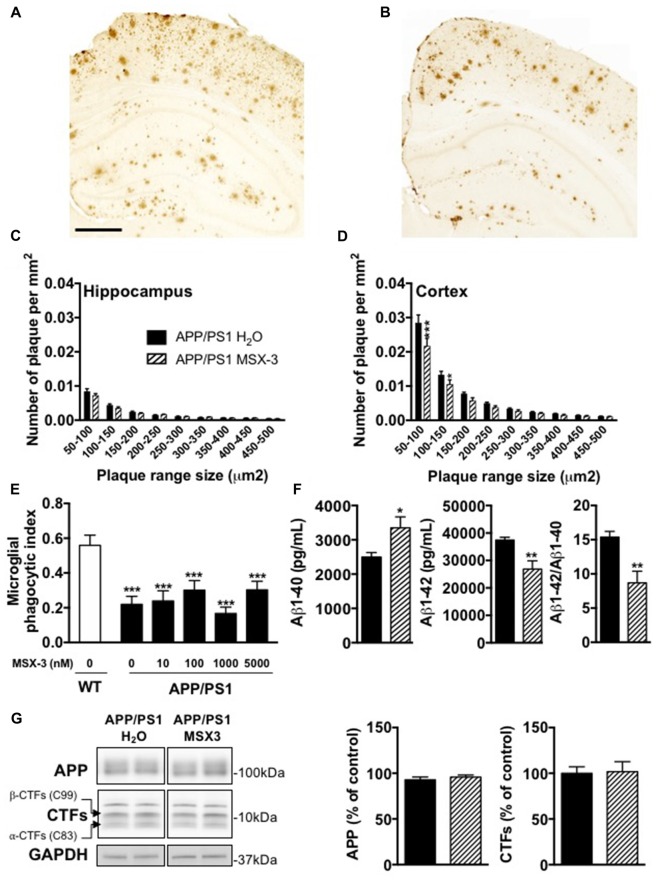
Impact of MSX-3 treatment on amyloid load, Aβ levels and phagocytic capacity of microglia in APP/PS1 mice. Representative images of 6E10 staining in the brains of 10 months old APP/PS1 treated with water (A) or MSX-3 (B). Scale bar = 500 μm. Distribution of amyloid plaques size were examined in the hippocampus (C) and cortex (D) of APP/PS1 mice. We found that the treatment with MSX-3 significantly reduced, in the cortex (D) but not in the hippocampus (C), the density of plaques of lower size (between 50–150 μm2) as compared with APP/PS1 H2O animals (50–150 μm2, p < 0.001; 100–150 μm2, p < 0.05 vs. APP/PS1 H2O using Two-Way ANOVA followed by LSD Fisher post hoc test; N = 7–9/group). (E) Effect of acute MSX-3 treatment on microglial phagocytic index determined in an in situ live cerebral slice assay of 12-month-old APP/PS1-Csf1r-EGFP mice and Csf1r-EGFP wildtype littermates after 60 min pre-incubation with the indicated concentration of MSX-3. Datasets were tested for significance with the One-way ANOVA and represent data from three independent experiments. ***p < 0.001 vs. WT (F) As measured by ELISA, MSX-3 treatment decreased Aβ1–42 levels in the cortex of APP/PS1 mice while Aβ1–40 levels was found increased. Overall, the Aβ1–42/Aβ1–40 ratio was found significantly reduced by the A2A antagonist treatment (*p < 0.05, **p < 0.01 vs. APP/PS1 H2O using Student’s t-test; N = 7–11/group). (G) Western blot analysis performed in cortex of water and MSX-3 treated APP/PS1dE9 mice did not revealed any change in APP and Carboxyterminal fragments (CTFs) expression (N = 6/group). Results are expressed as mean ± SEM.